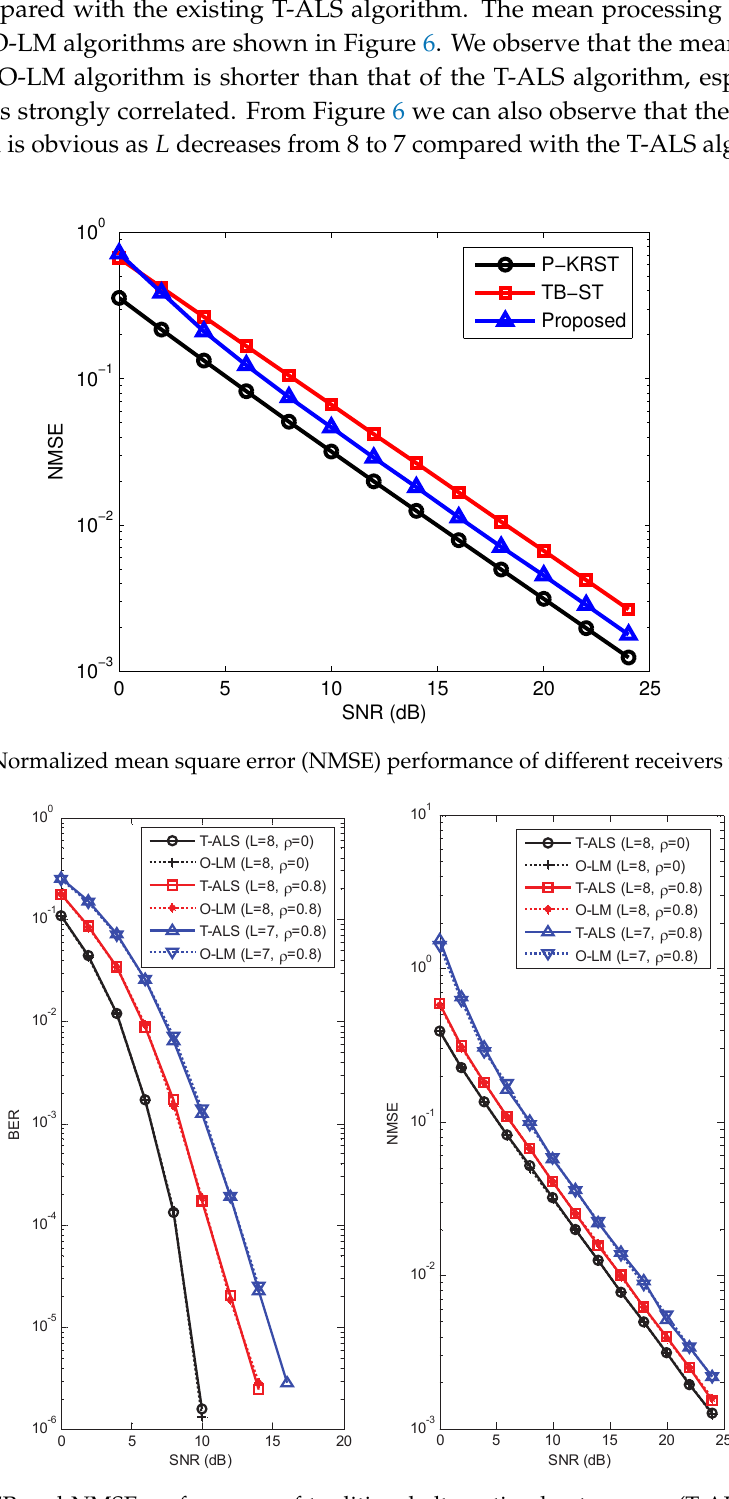
Figure 5. BER and NMSE performance of traditional alternating least squares (T-ALS) and O-LM algorithms for different L and ρ